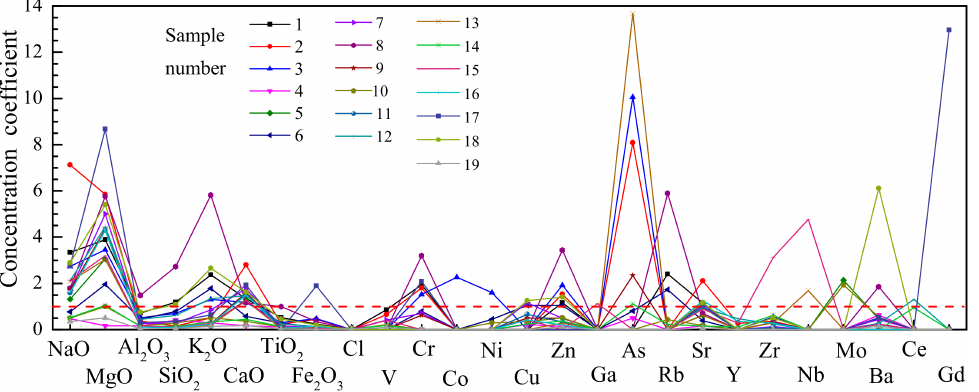
Figure 3. Concentration coefficients (CC, ratio of element concentration in investigated coals vs. average Chinese